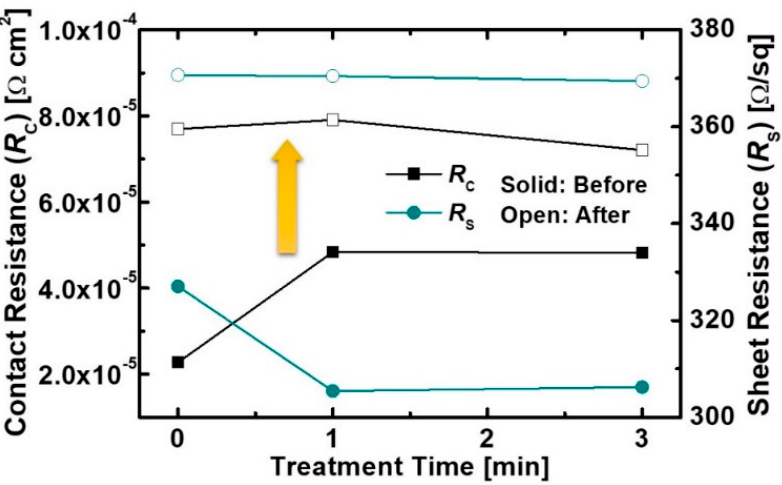
Figure 3. Sheet and contact resistances obtained from the transmission line method (TLM) of samples with and without treatment for 3 min before and after the proton irradiation.